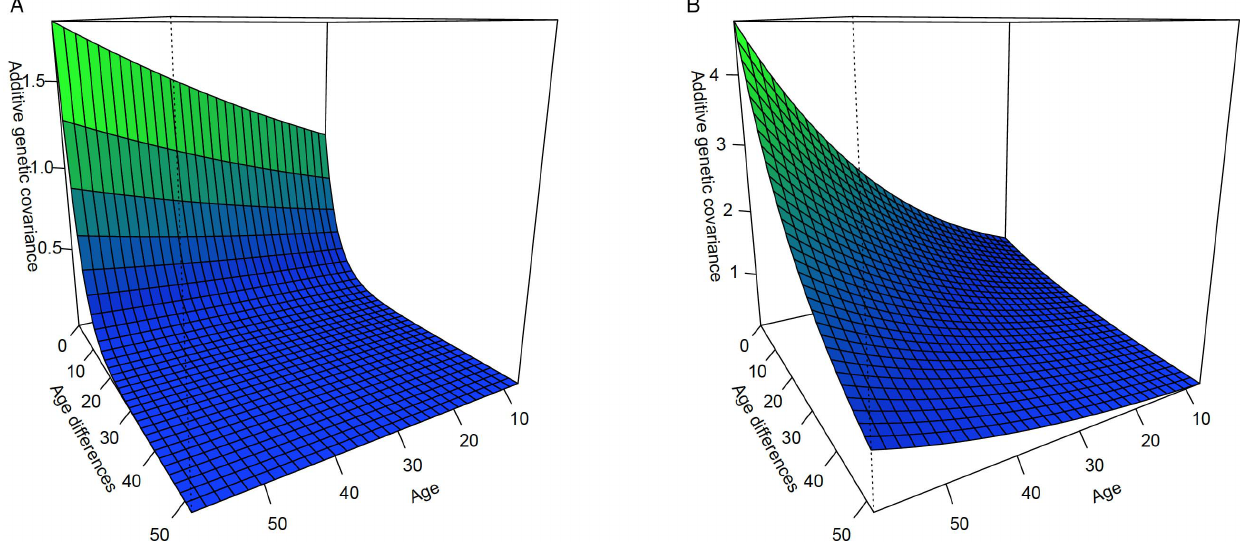
Figure 2. Genotype X Age for PC (A) and Sed (B).